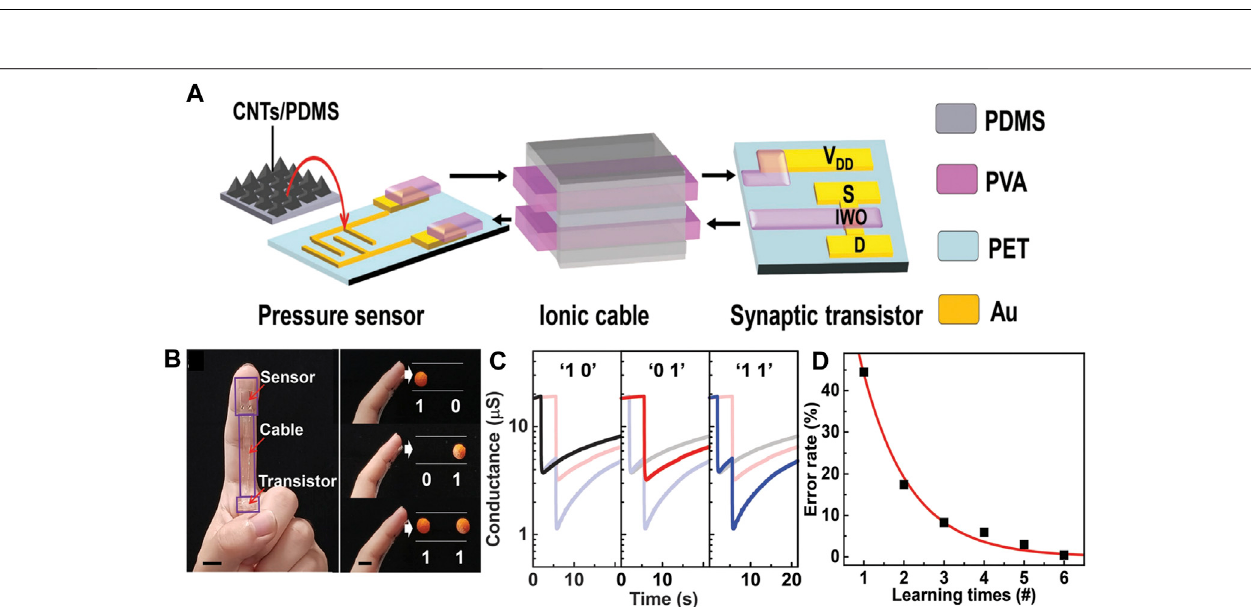
FIGURE 6 | (A) Diagram illustrating the details of the NeuTap. (B) Schematic diagram of the digital image and pattern pair of NeuTap on the fi nger and the correspondingtwo-digitbinarycodelabel. (C) NeuTap ’ sresponsetothreetypesofpatternpairs. (D) Recognitionerrorrateplottedasafunctionoflearningtime(adapted from Wan et al.,